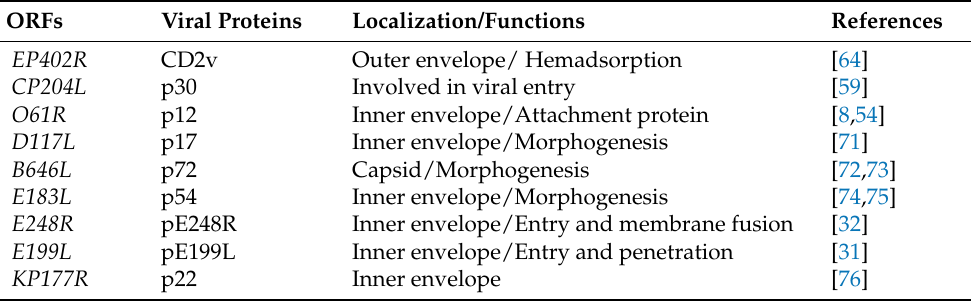
Table 1. The functional roles of ASFV structural proteins involved in virus